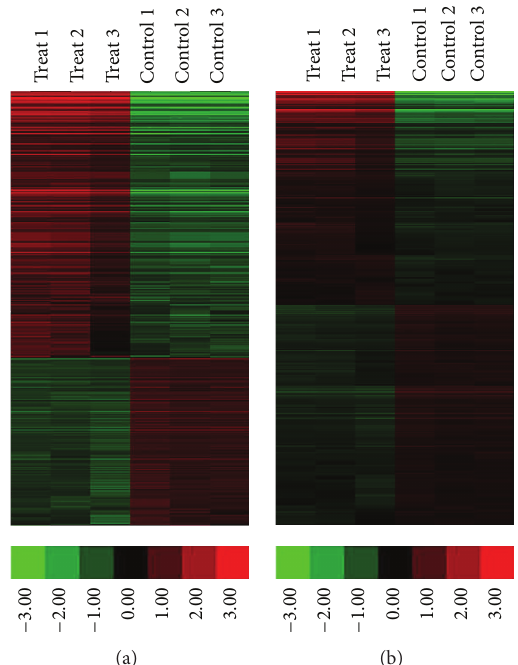
Figure 1: Profile of microarray data. (a) Hierarchical clustering shows a distinguished lncRNAs expression profiling among groups. (b) Hierarchical clustering shows a distinguished mRNAs expression profiling among groups. The red and the green shades indicate the expression above and below the relative expression, respectively, across all samples.